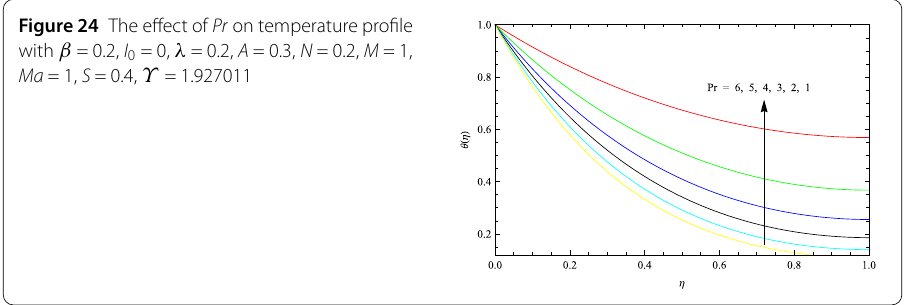
Figure 24 The effect of Pr on temperature profile with β = 0.2, I 0 = 0, λ = 0.2, A = 0.3, N = 0.2, M = 1, Ma = 1, S = 0.4, Υ =